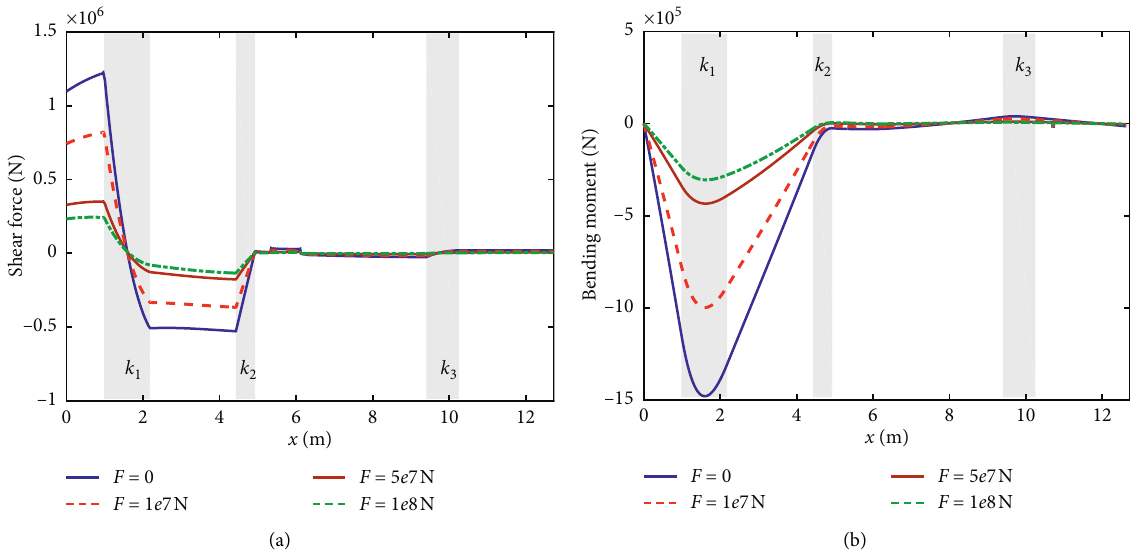
Figure 11: Internal force in propulsion shafting with various thrust forces. (a) Shear force; (b) bending